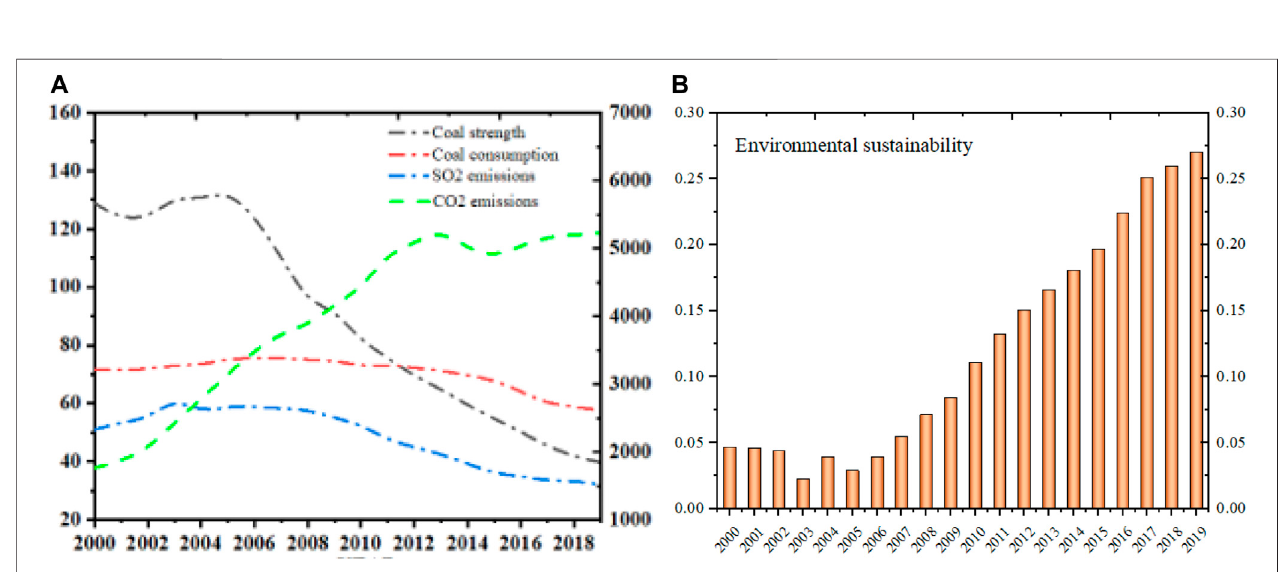
FIGURE 6 | Environmental sustainability results from 2000 to 2019: (A) indicator value; (B) dimension value.